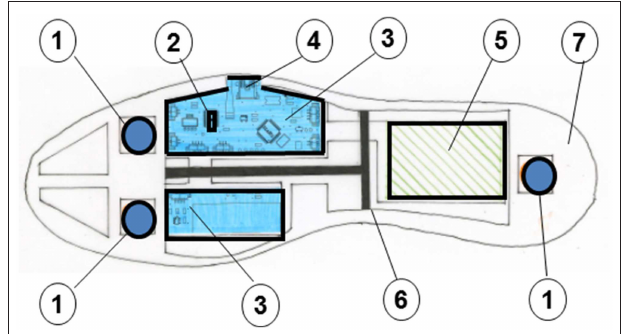
FIGURE 1 | Details of the vibrating insole: (1) vibrating micro-motors; (2) microprocessor; (3) electronic device; (4) USB connector; (5) battery; (6) support sole; (7) superior membrane.